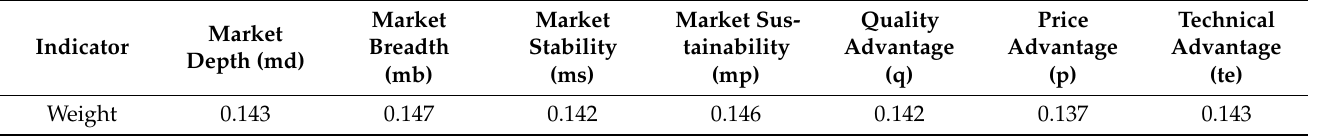
Table 3. The index weights of international competitiveness of forest